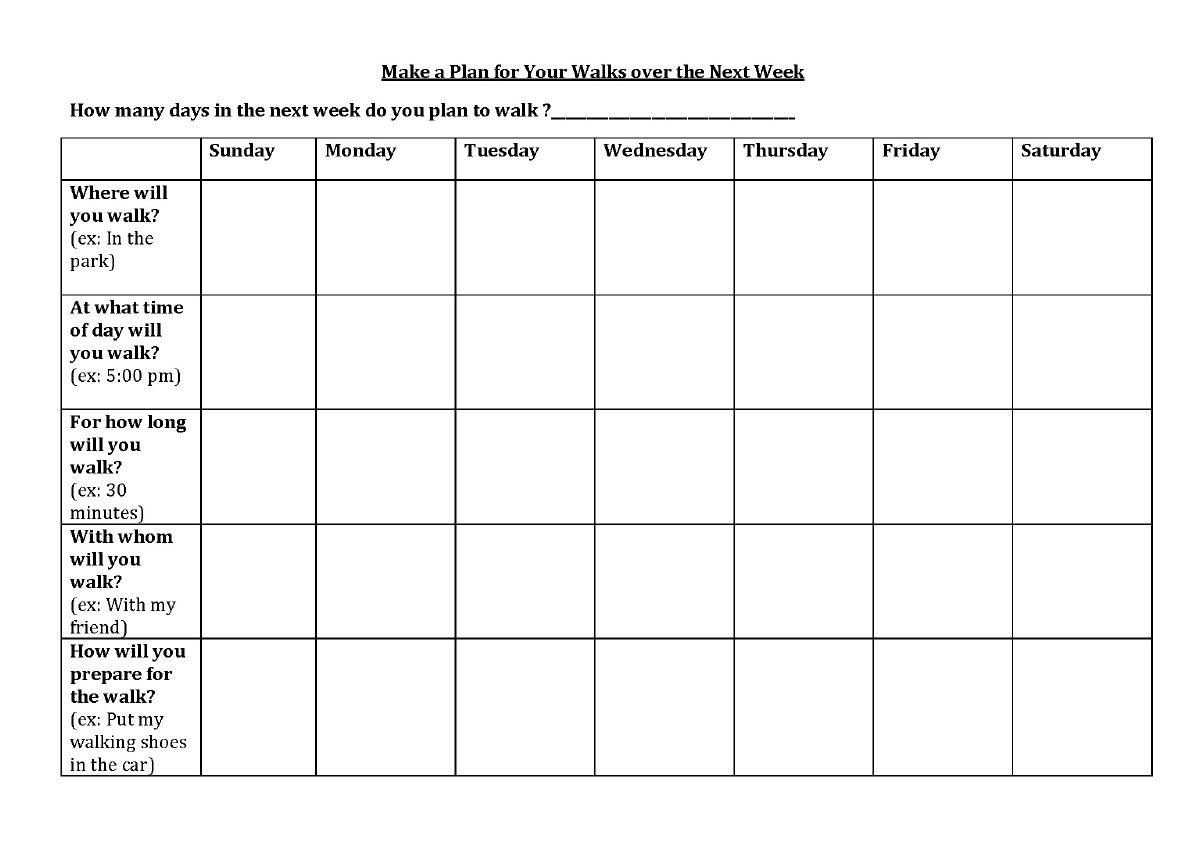
Figure 3. Walking plan to be completed by intervention